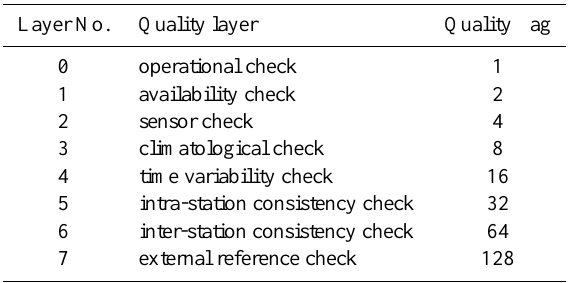
Table 3. Maximum period of linearly interpolated